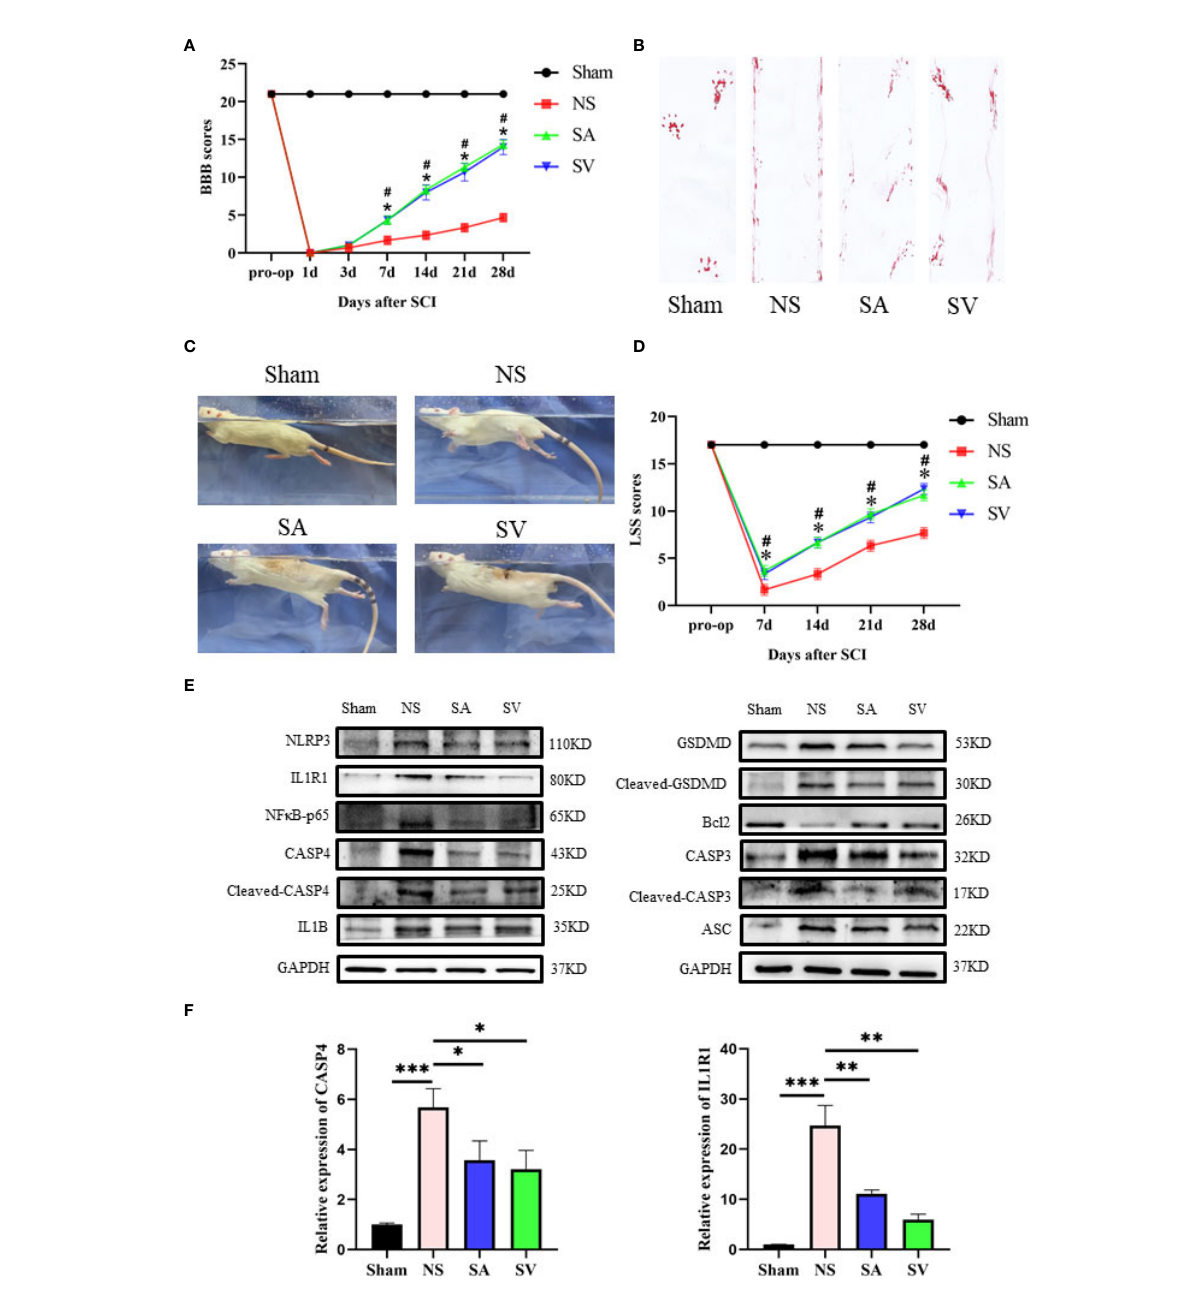
FIGURE 6 Change of the biomarkers and functional recovery in the SCI model after immunosuppressive therapy. (A) Statistical analysis of the BBB Scale in Sham, positive control, and treatment groups over 28 days (n = 3 rats per group at each time point, values are the mean ± SD, *p < 0.05, t-test). (B) Footprint analysis of different groups. (C, D) Statistical analysis of the Louisville Swim Scale in the four groups over 28 days (n = 3 rats per group at each time point, values are the mean ± SD, *p < 0.05, t-test). (E) Western blot showed that the expression level of the biomarkers in the treatment groups was between the levels of sham and control groups, and the levels of Bcl2 and CASP3, NF k B, GSDMD, IL1B, ASC, and CASP3 in SA and SV groups were also between those of Sham and control groups (n = 3 rats per group, *p < 0.05, **p < 0.01, ***p < 0.001, t- test). (F) RT-qPCR showed that the level of biomarkers was signi fi cantly decreased after treatment (n = 3 rats per group, *p < 0.05, **p < 0.01, ***p < 0.001,